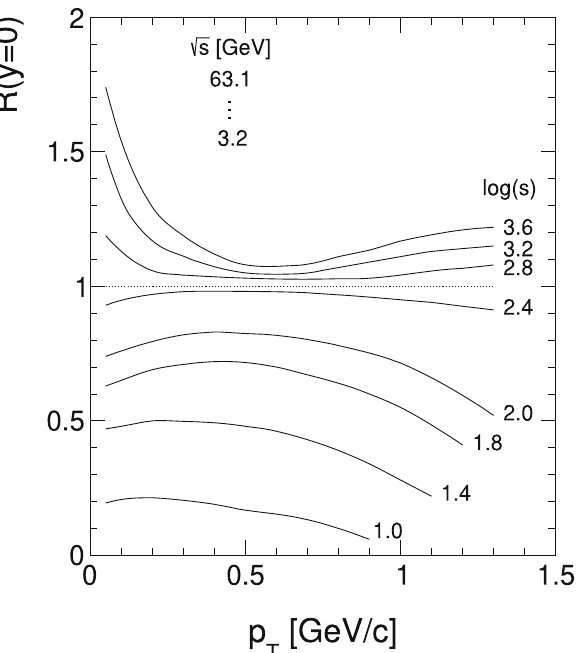
Fig. 121 R ( y = 0 , s , p T ) as a function of p T for the reference data, log ( s ) from 1.0 to 3.6